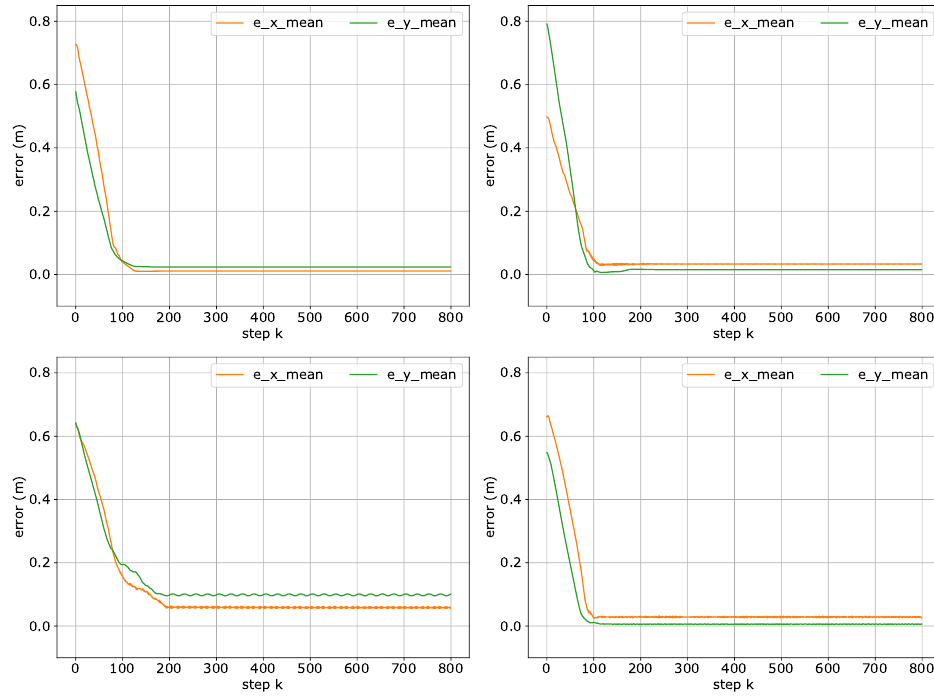
Figure 6. Error x and y for example result for U control type, c 8 cost type, Gaussian White Noise Process and δ = 0.8.